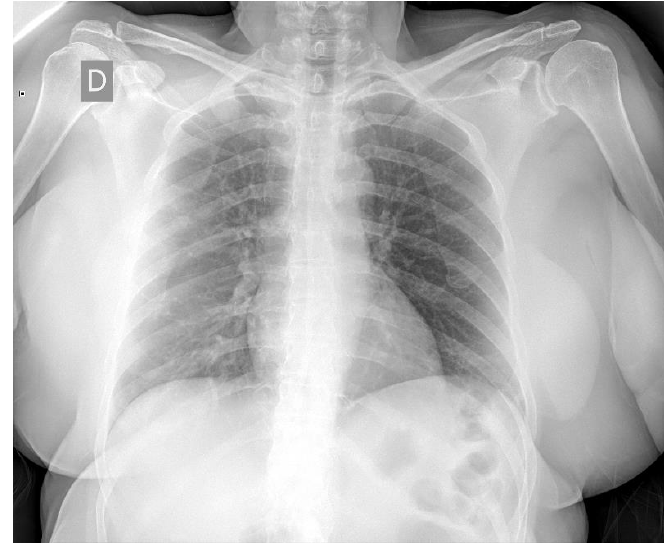
Figure 6. Chest radiograph example from the BIMCV COVID-19 dataset marked by radiologists.